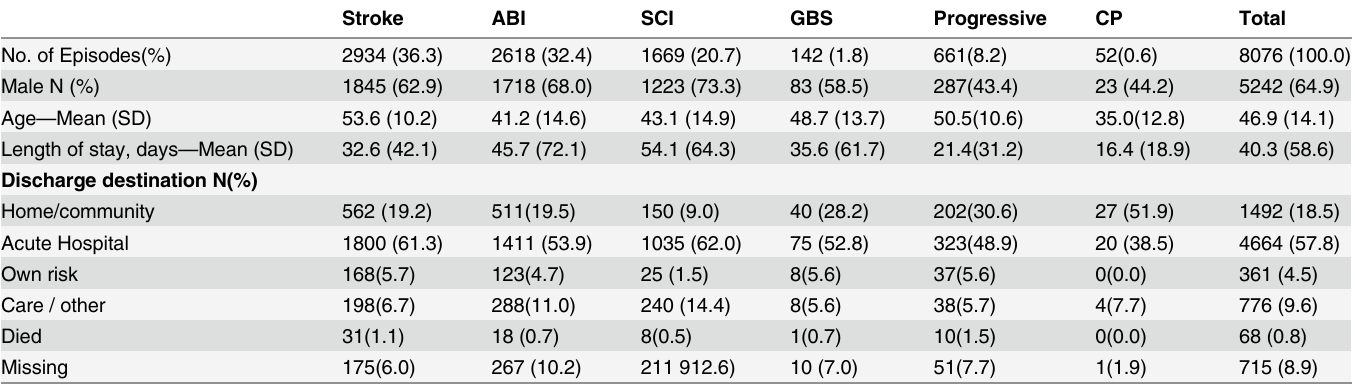
Table 3. Characteristics of the incomplete episodes (n = 8076).